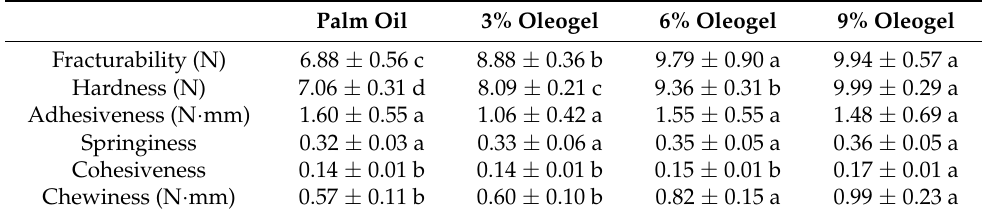
Table 2. Effect of palm oil replacement with oleogels on the texture properties of imitation cheeses.